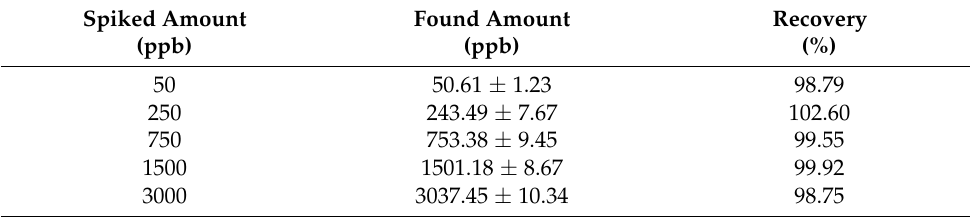
Table 3. Determination of DON in pasta sample through the proposed immunosensor. Spiked Amount Found (ppb)